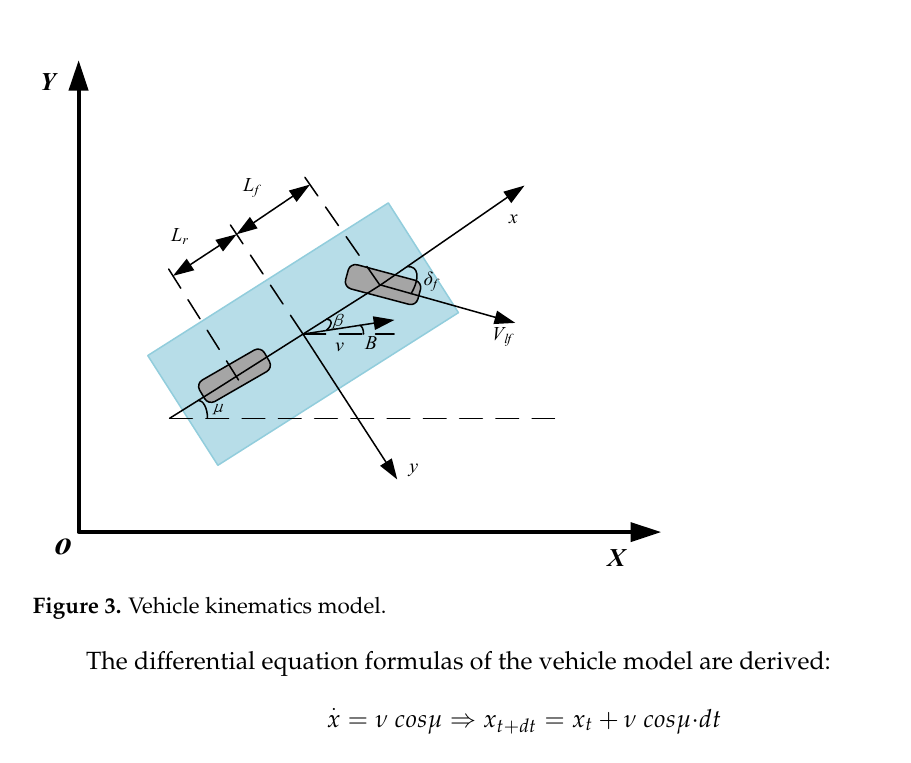
( b ) Figure 2. Target bias comparison diagram. ( a ) The basic RRT; ( b ) the improved RRT. 2.2. Random Point Expansion Optimization When using RRT to plan the vehicle path, considering the vehicle kinematics con- straints and limiting the sampling area can better meet the driving requirements of the vehicle steering mechanism and the vehicle following control requirements. The two-de- gree-of-freedom vehicle motion model is established with the center of the vehicle ′ s rear axle as the reference point. The vehicle kinematics model is shown in Figure 3, (x , y) are